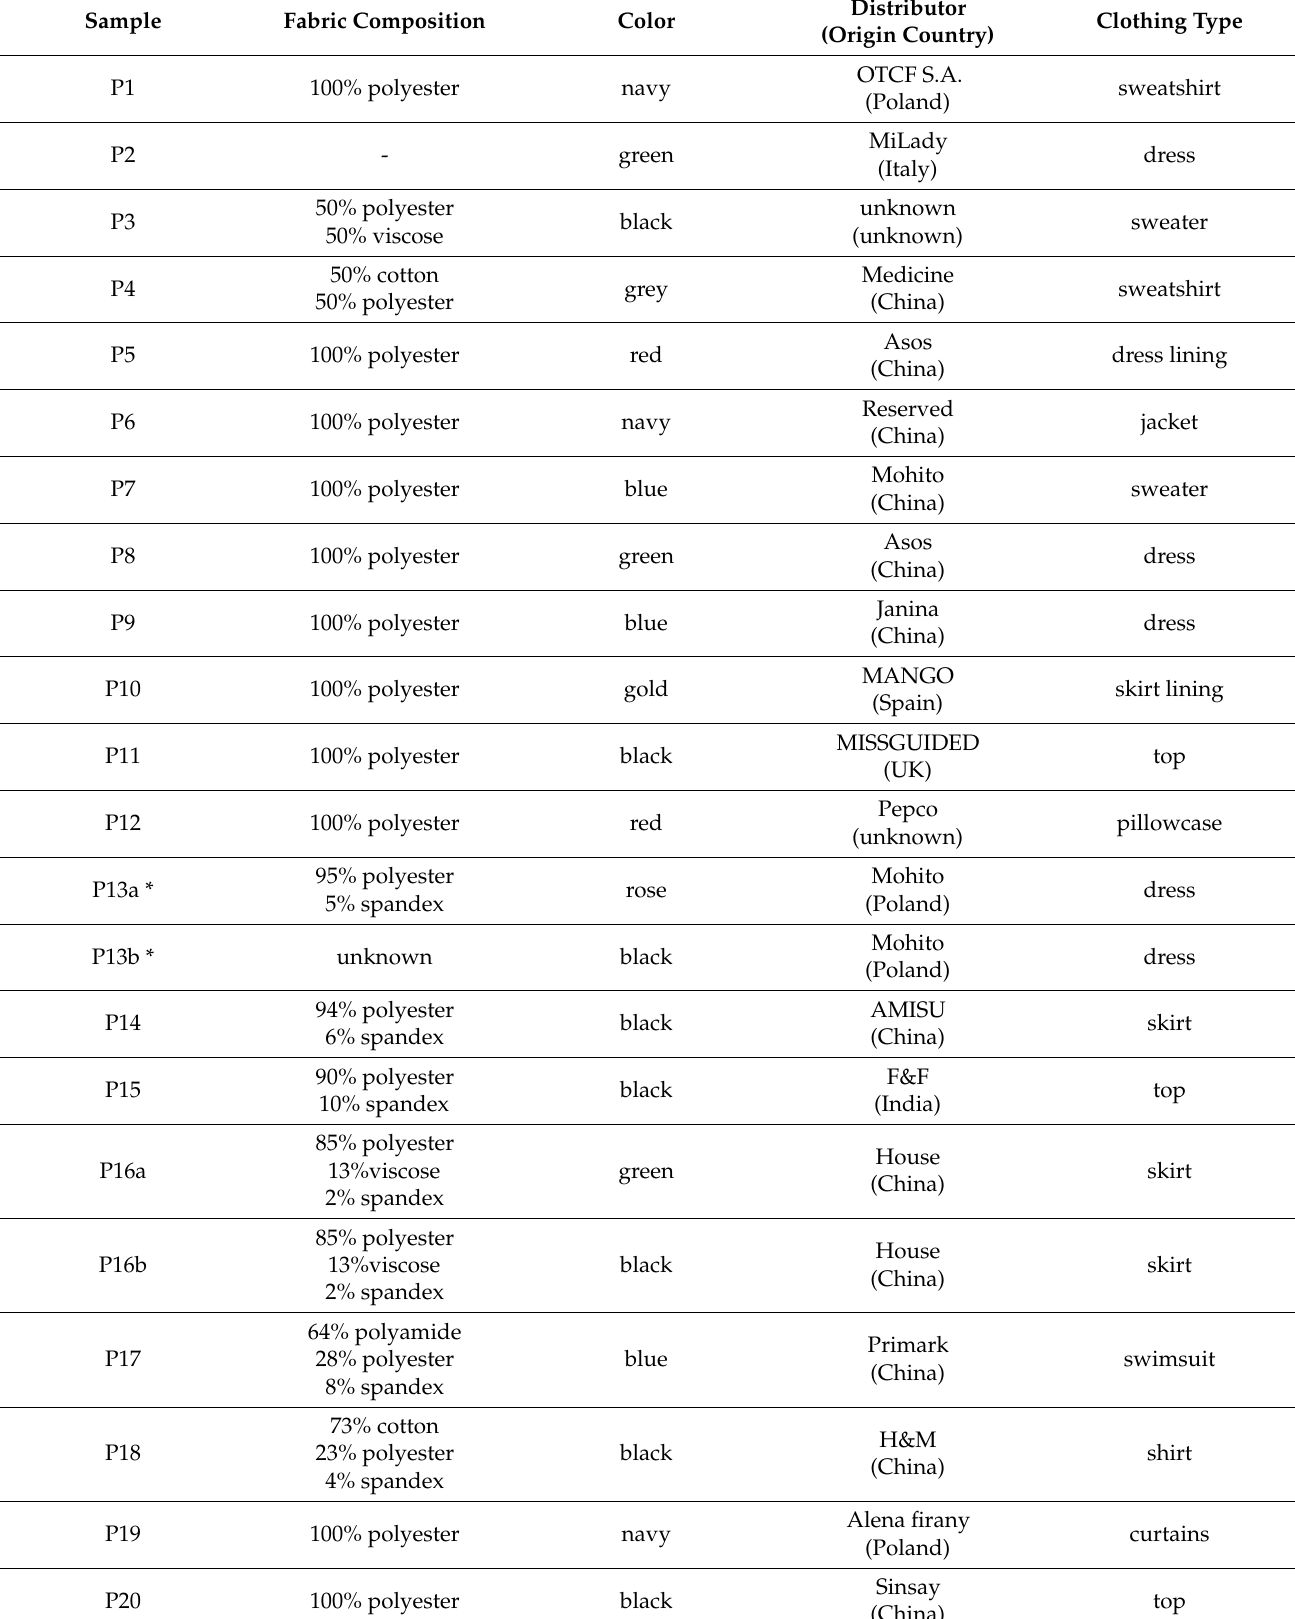
Table 7. The real sample used in